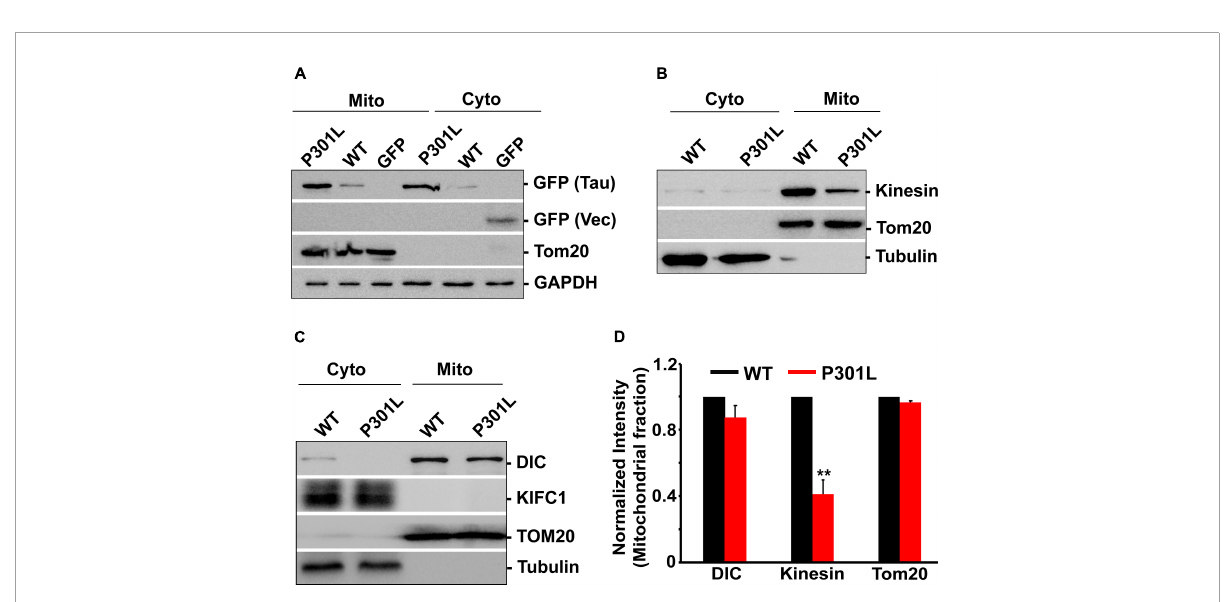
FIGURE4 P301L inhibits kinesin recruitment to mitochondria: (A) Representative immunoblot showing the association of wild-type and mutant form tau with mitochondria. (B,C) Representative immunoblots showing the mitochondrial abundance of dynein and kinesin motors in cells expressing GFP Tau WT and GFP Tau P301L. Tom20, an outer mitochondrial membrane protein, was used as a mitochondrial marker. GAPDH or tubulin was used as cytosolic markers. KIFC1 was used as a negative control. (D) Quantitative analysis showing the mitochondrial association of kinesin and dynein in wild-type and P301L cells. Data were obtained from three independent experiments, and error bars represent SEM. ** P <